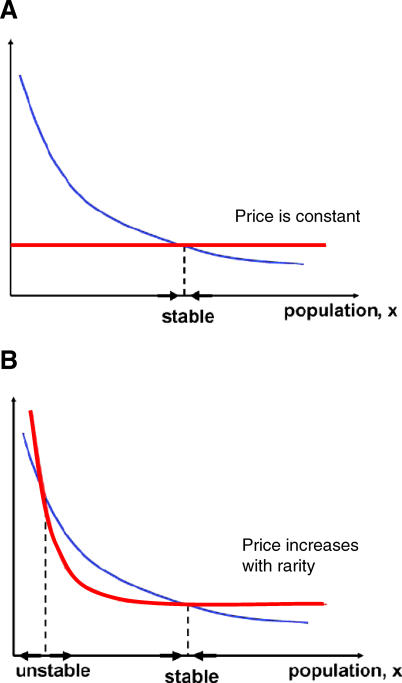
Demonstration of an Anthropogenic Allee Effect with a Simple Model of an Exploited PopulationThe price (red, thick line) and cost (blue, thin line) per unit harvest in unit time as a function of the population density x when (A) the price is independent of x and (B) the price increases with rarity. The system is in equilibrium whenever the red and blue lines meet, and the bold arrows represent how the population responds when perturbed from equilibrium. In (B), an increased price at low population density induces an Allee Effect.